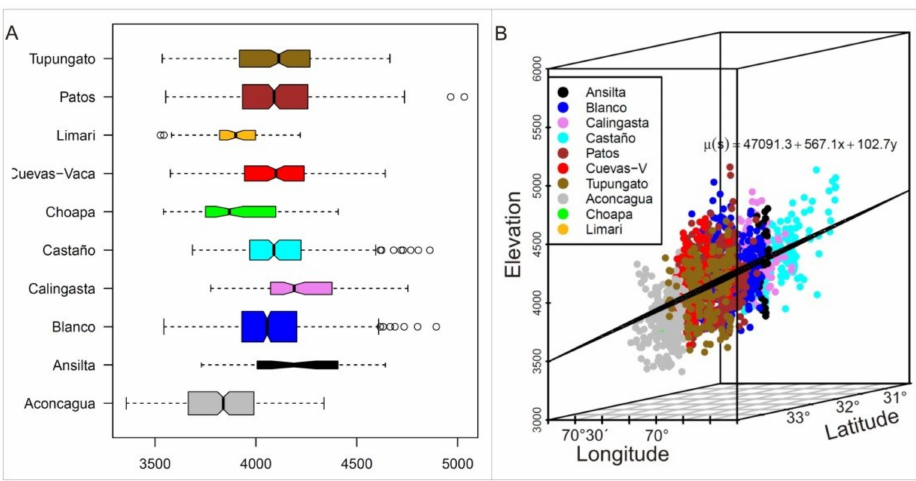
Figure 5. ( A ) Box and whisker plot considering the elevations of rock glaciers by basin. The width of the boxes is proportional to the amount of rock glaciers per basin. ( B ) Scatter diagram of elevation with respect to latitude and longitude.